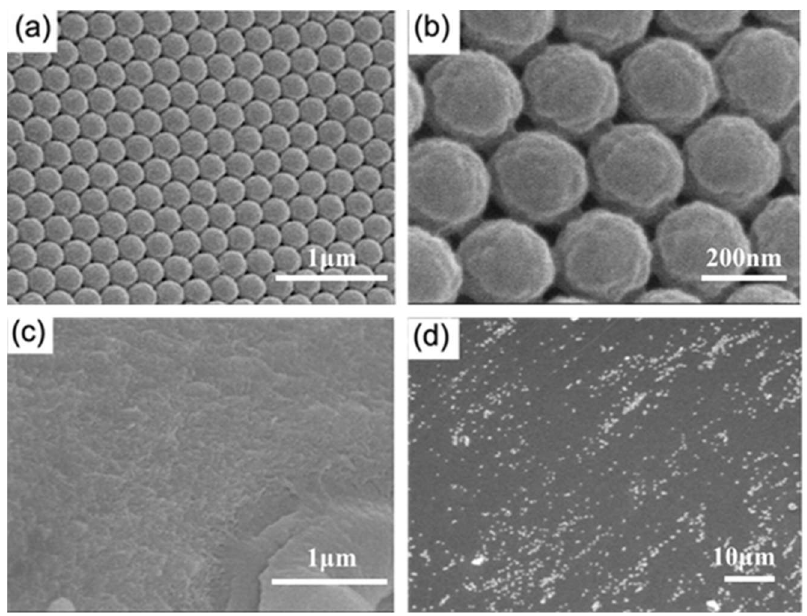
Figure 3. The SEM of the SF-PNIPAM dual-crosslinked nanocomposite film dried at room temperature ( a ) front of the PCs, ×35,000; ( b ) front of the PCs, ×130,000; ( c ) the film surface, ×35,000; ( d ) the film surface, ×1500.